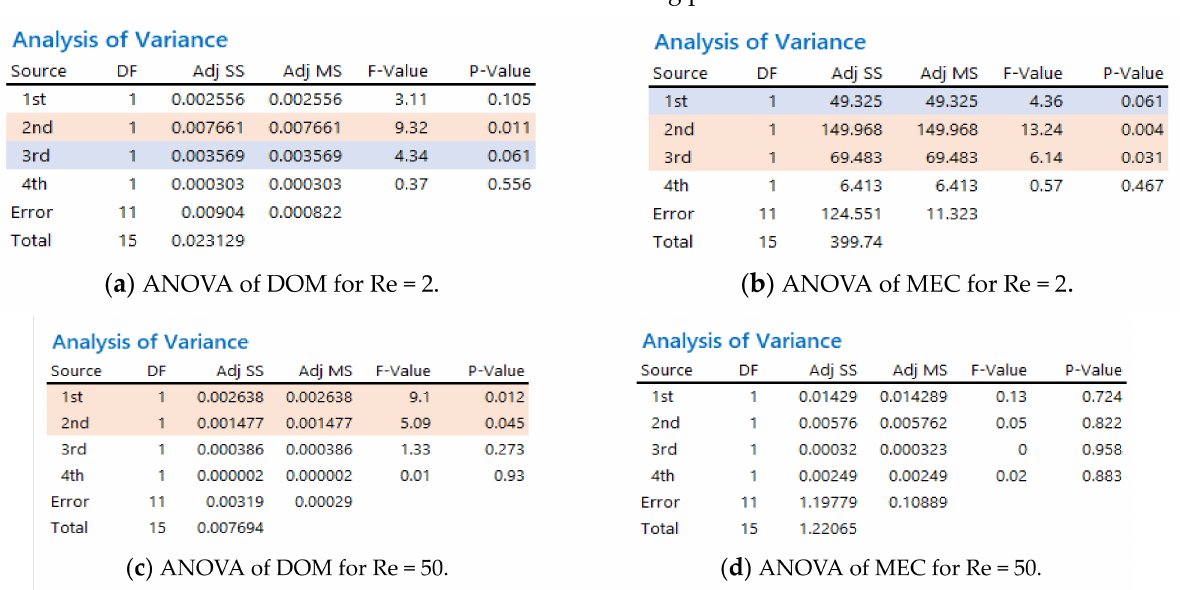
Figure 13. Statistical analysis of the combination scheme (B) for four combination